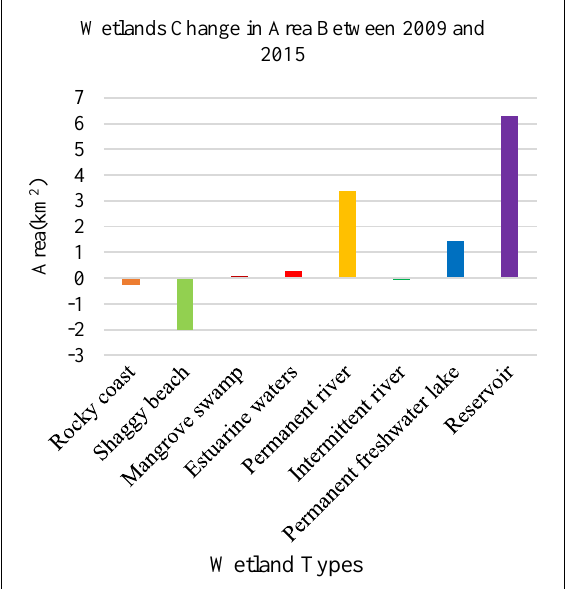
Figure 3. Loss and Gain in Area of Wetland During